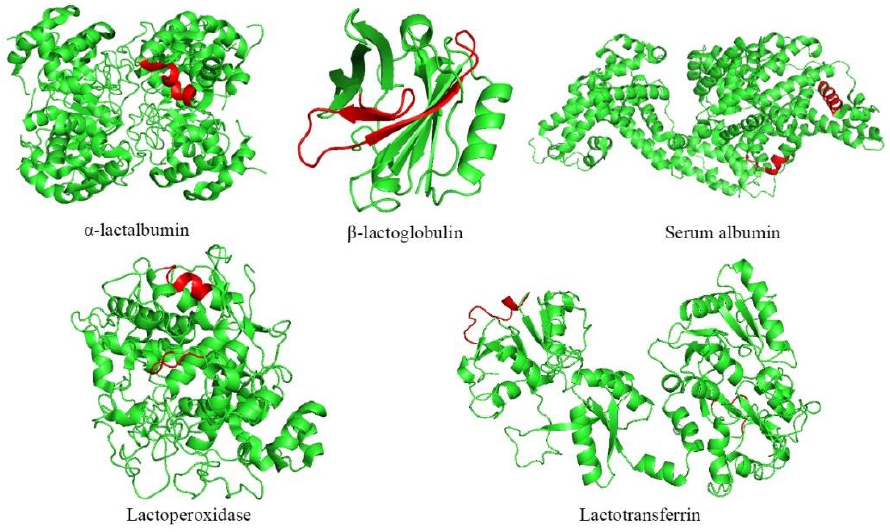
Figure 7. 3D structure of potential binding regions in WPI (red regions indicate the potential binding regions with FVPs).